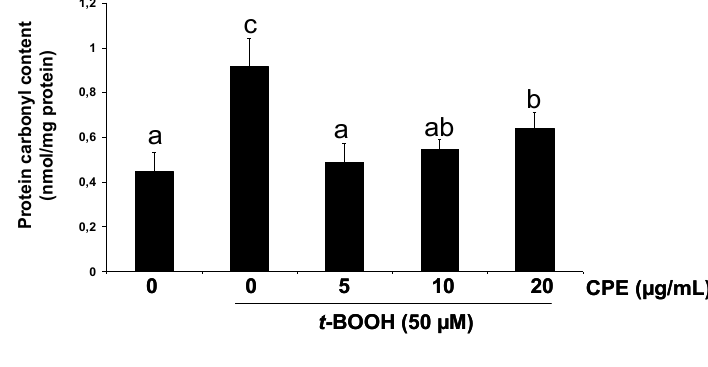
Figure 4. Protective effect of CPE on carbonyl group production. Ins-1E cells were treated with 5–20 μg/mL CPE for 20 h and then treated with 50 μM t -BOOH for 2 h and carbonyl groups were determined. Values are means ± SD of 4–5 different samples per condition. Different letters upon symbols indicate statistically different data ( p <